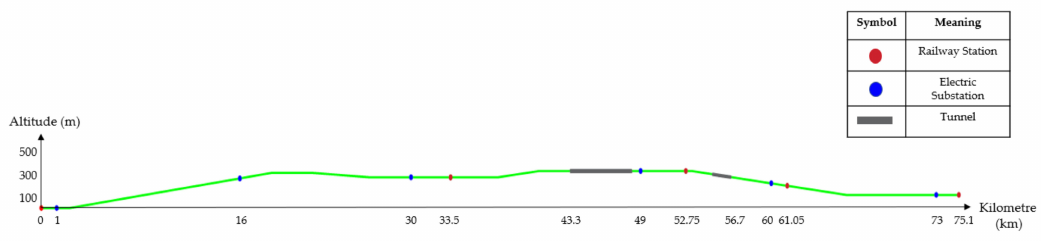
Figure 5. Characteristics of the railway line.